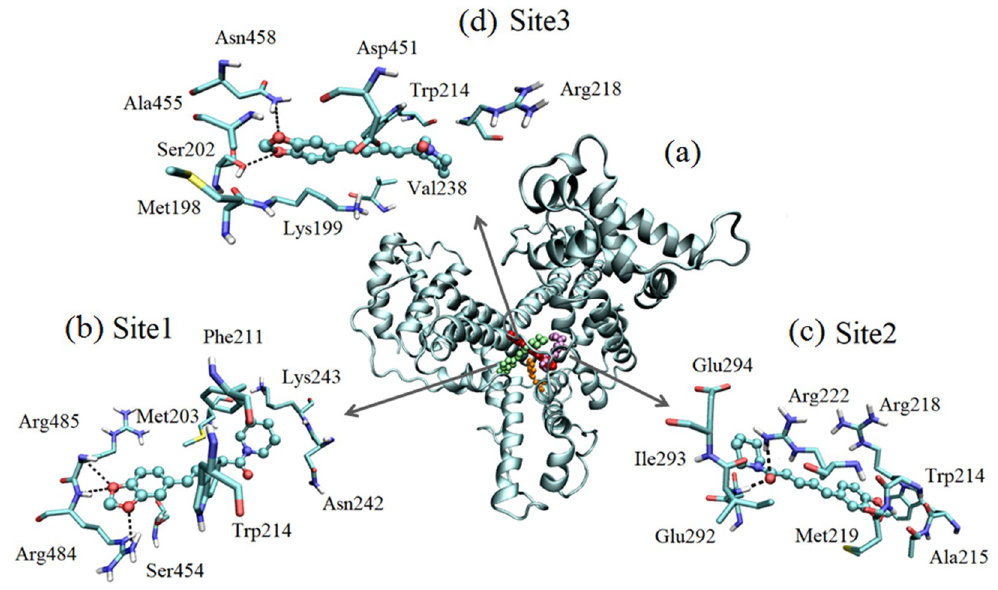
Figure 9. ( a ) The central picture represents the molecular docking. In orange is Trp214. The piperine molecules are in green (site 1), in purple (site 2), and in red (site 3). Frame ( b ) represents site 1, ( c ) site 2, and ( d ) site 3, with dotted lines indicating the hydrogen bonds.